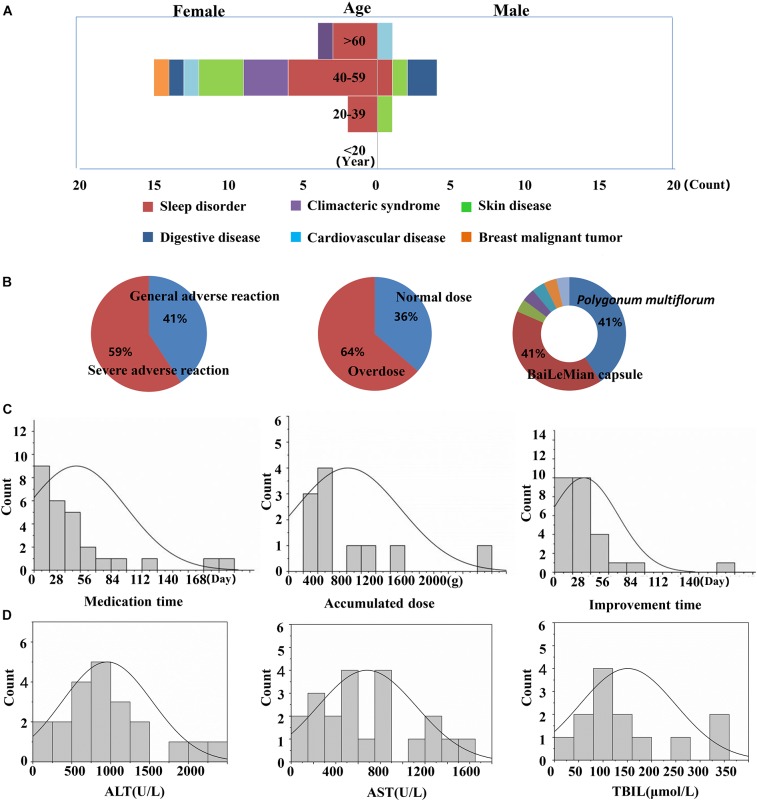
Clinical features of PM-induced liver injury and related risk factors. (A) Liver injury cases of gender, age and the purpose of medications; (B) degree of adverse drug reaction, dose distribution and drug type distribution; (C) time of liver injury for taking the medicine, accumulated dose and improvement time; (D) biochemical indicators (ALT, AST, and TBIL).